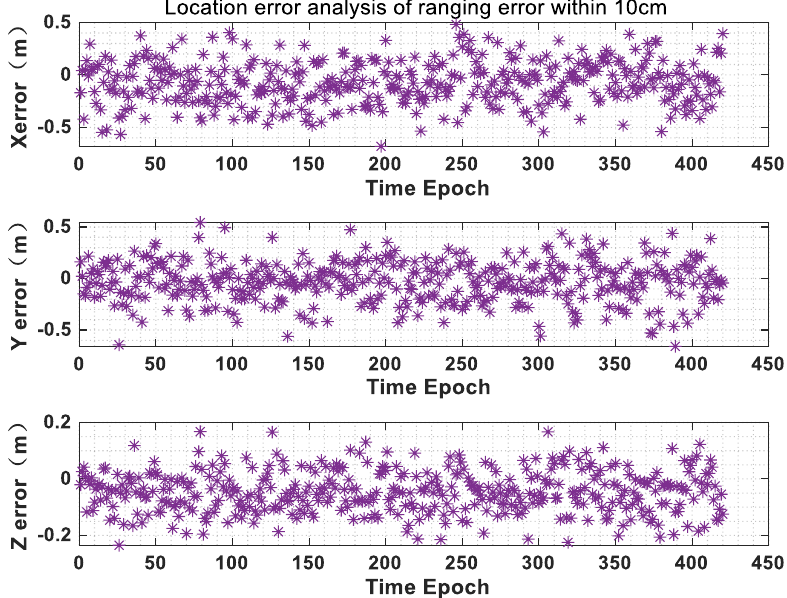
Figure 14. Positioning accuracy analysis when ranging accuracy is within 10 cm.